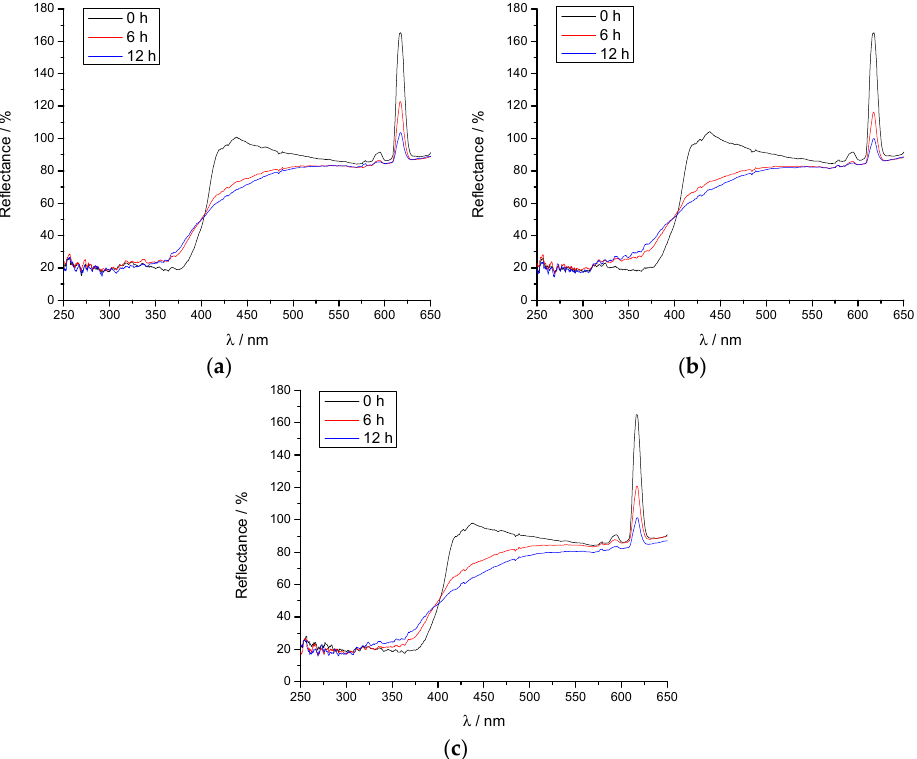
Figure 6. Spectral reflectance of unaged and aged coatings: ( a ) FC + 0.5% TiO 2 ; ( b ) FC + 1% TiO 2 ; ( c ) FC + 1.5% TiO 2 .